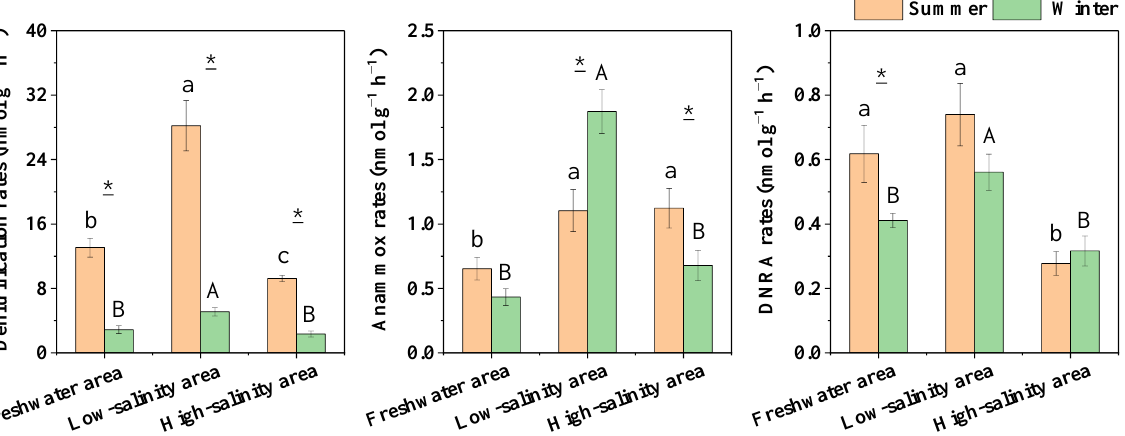
Figure 3. Sediment NO 3 ‒ reduction process rates in the freshwater, low-salinity and high-salinity area. Different lowercase and uppercase letters indicate significant spatial differences ( p < 0.05), and the asterisks denote significant seasonal differences ( p < 0.05). In NO 3 − reduction processes, denitrification was the dominant pathway, contributing 86.83 to 93.85% and 67.52 to 72.51% to the gross NO 3 − reduction in summer and winter,